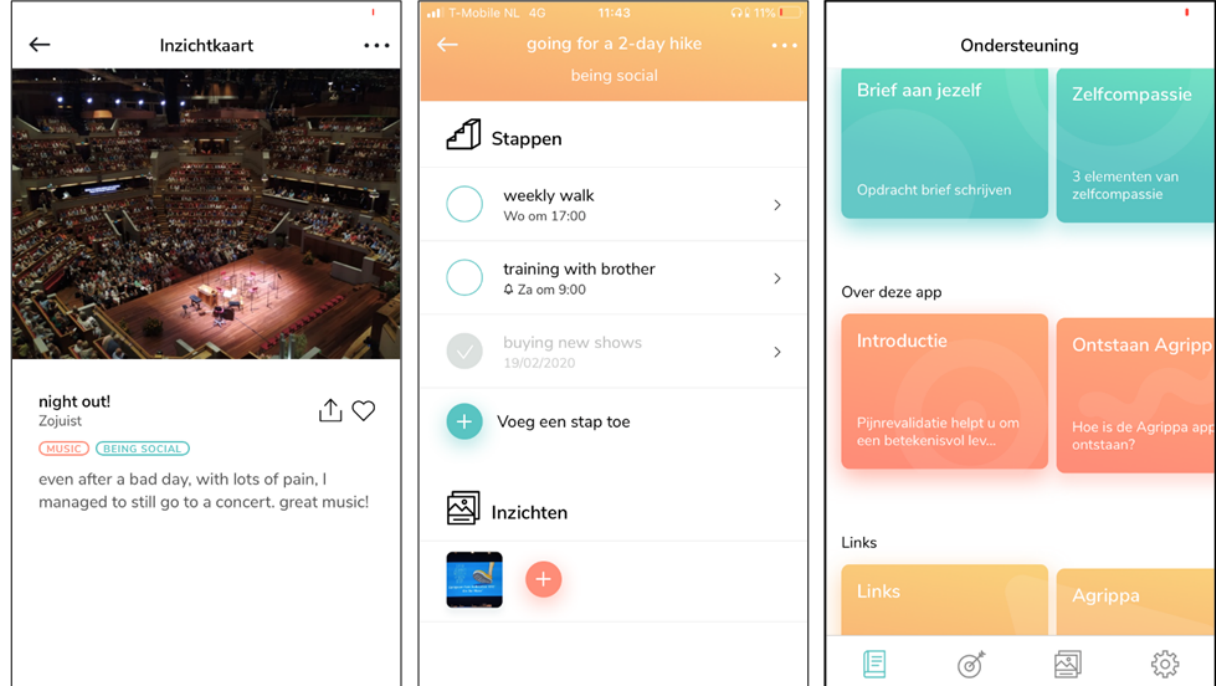
Figure 1. Three screenshots from the AGRIPPA app. Left: example of an insight card, including a related photo, title, two associated values, and description. Middle: Overview of a fictitious goal to go for a hike, including three steps and a related insight. Right: Overview screen of the education and information module. The first row includes treatment-specific exercises, the second row includes general information about the app, and the third row includes links to other support